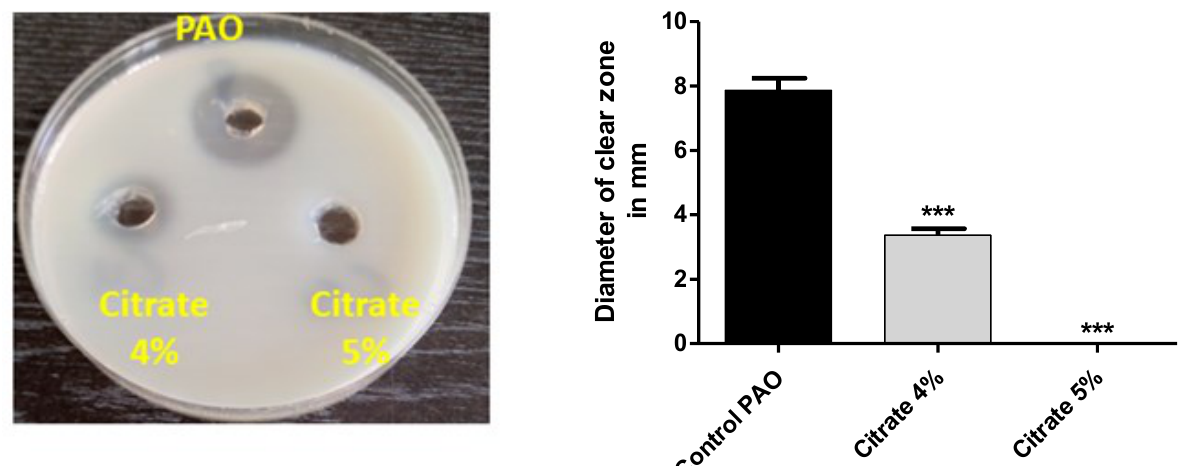
Figure 5. Sodium citrate decreases the activity of protease. The clear zones due to proteolytic effects of collected protease from cultures provided or not with 4% or 5% sodium citrate on skim milk agar were measured. Sodium citrate significantly reduced protease production (*** = p < 0.0001).